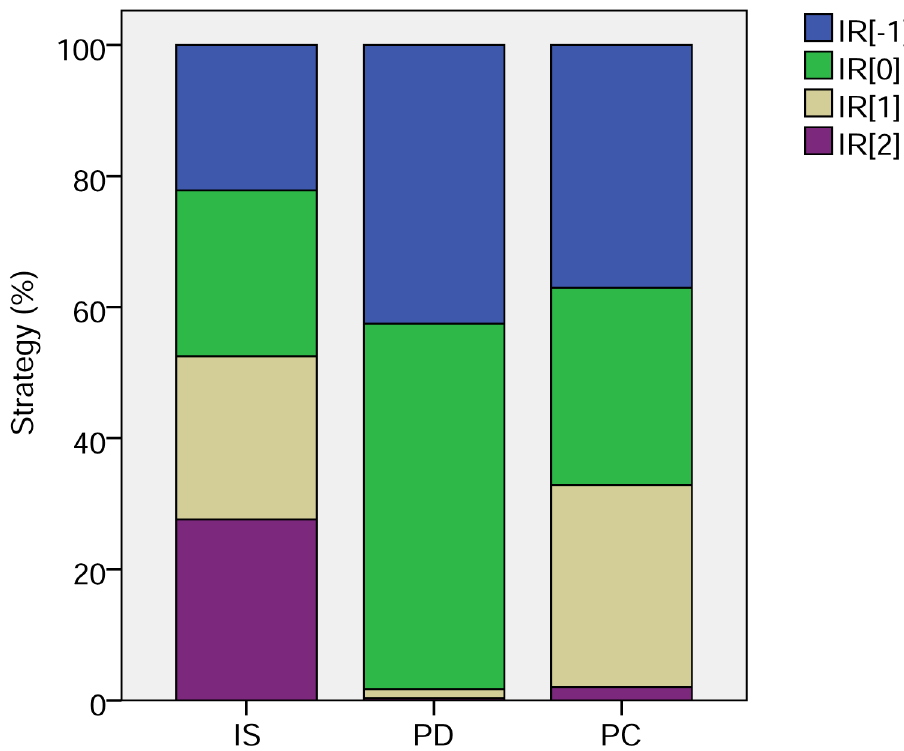
Fig 2. Strategies of image scoring and partner choice. Strategy mixes with pure image scoring with random assignment (IS); incorporating phenotypic defectors (PD); and with partner choice (PC). Strategies are labelled as IR[ k ] where k is the strategy threshold. Thus k = -1 denoted individuals that cooperated unconditionally; k = 0 strategists cooperated providedtheir partner had never played or had cooperated; k = 1 strategists cooperated providedthe partner had cooperated; and k = 2 strategists never cooperated. Proportions are shown as means over 10 simulations of within simulation means calculated across 10,000